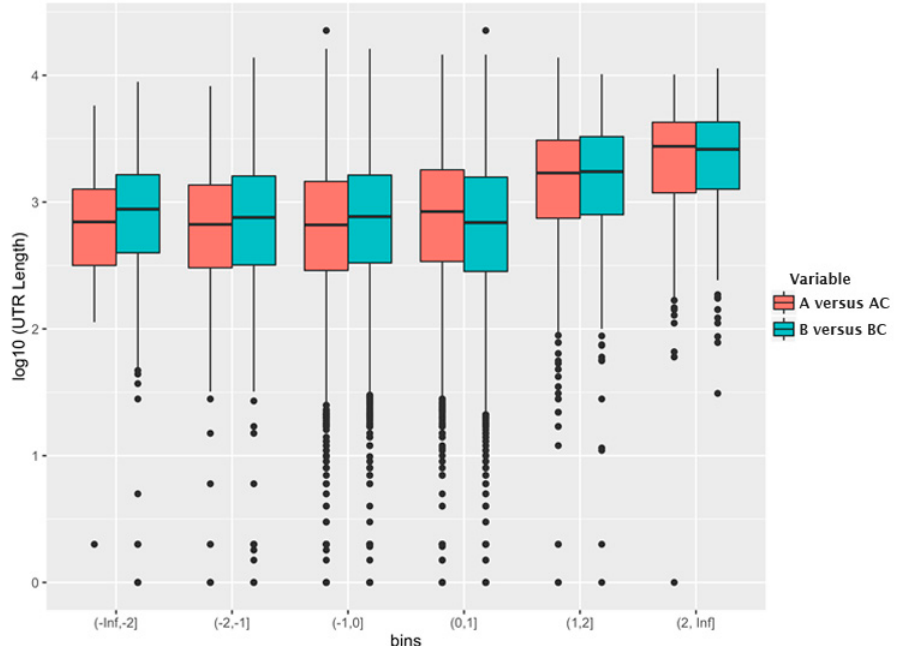
Figure 2. Relationship between bins of similar log 2 (fold change) on the x -axis and the log 10 (UTR length) on the y -axis. A, mRNAs encapsidated in HIV-1 virus-like particles (VLPs); AC, mRNAs in cells producing HIV-1 VLPs; B, mRNAs encapsidated in murine leukemia virus (MLV) VLPs; BC, mRNAs in cells producing MLV VLPs.